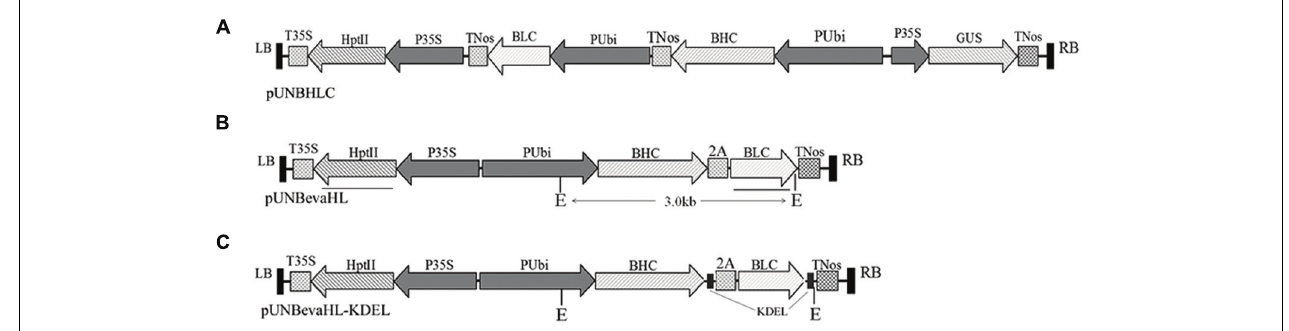
FIGURE 1 | T-DNA regions of constructs for rice transformation. (A) pUNBHLC construct with Bevacizumab LC (BLC) and HC (BHC) genes expressed in two expression cassette; (B) pUNBevaHL construct with BLC and BHC expressed as a polyprotein linked with a FMDV 2A self-cleavage peptide; (C) pUNBevaHL-KDEL construct with BLC and BHC expressed as a polyprotein as in (B) , but a KDEL ER retention peptide sequence was added to the C-termini of the coding regions of both BLC and BHC genes. Lysogeny broth (LB) and RB denote the left and right borders of the T-DNA region of the binary vector. TNos and T35S are terminators of the Agrobacterium nopaline synthase gene and the CaMV 35S expression cassette, respectively. 2A is the self-cleavage peptide from foot-and-mouth disease virus, and KDEL is the ER retention signal peptide. Two Eco RI (E) restriction enzyme digestion sites are indicated on pUNBevaHL and pUNBevaHL-KDEL constructs in (B , C) , and the ∼ 3 kb fragments flanked by the two Eco RI sites are indicated. The bars under pUNBevaHL construct (B) show the positions of HptII and BLC probes used in Southern blot